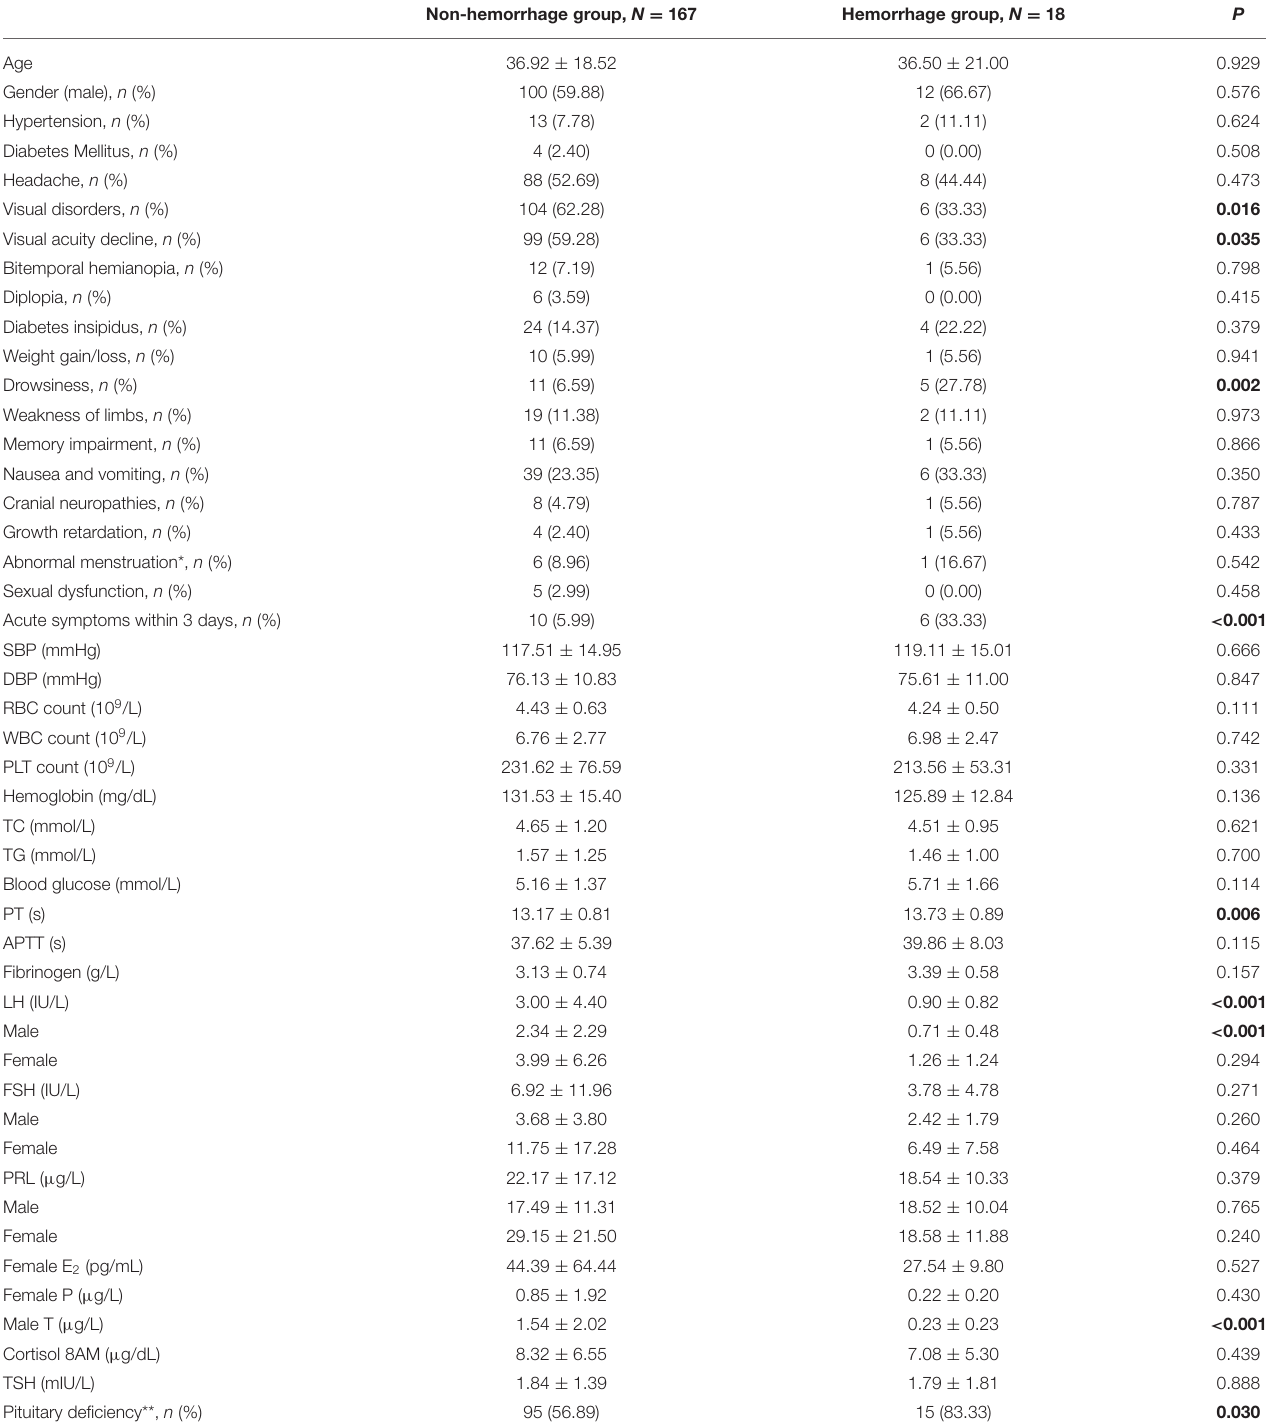
TABLE 1 | Baseline characteristics in patients with Craniopharyngioma (CP). Non-hemorrhage group, N = 167 Hemorrhage group, N =